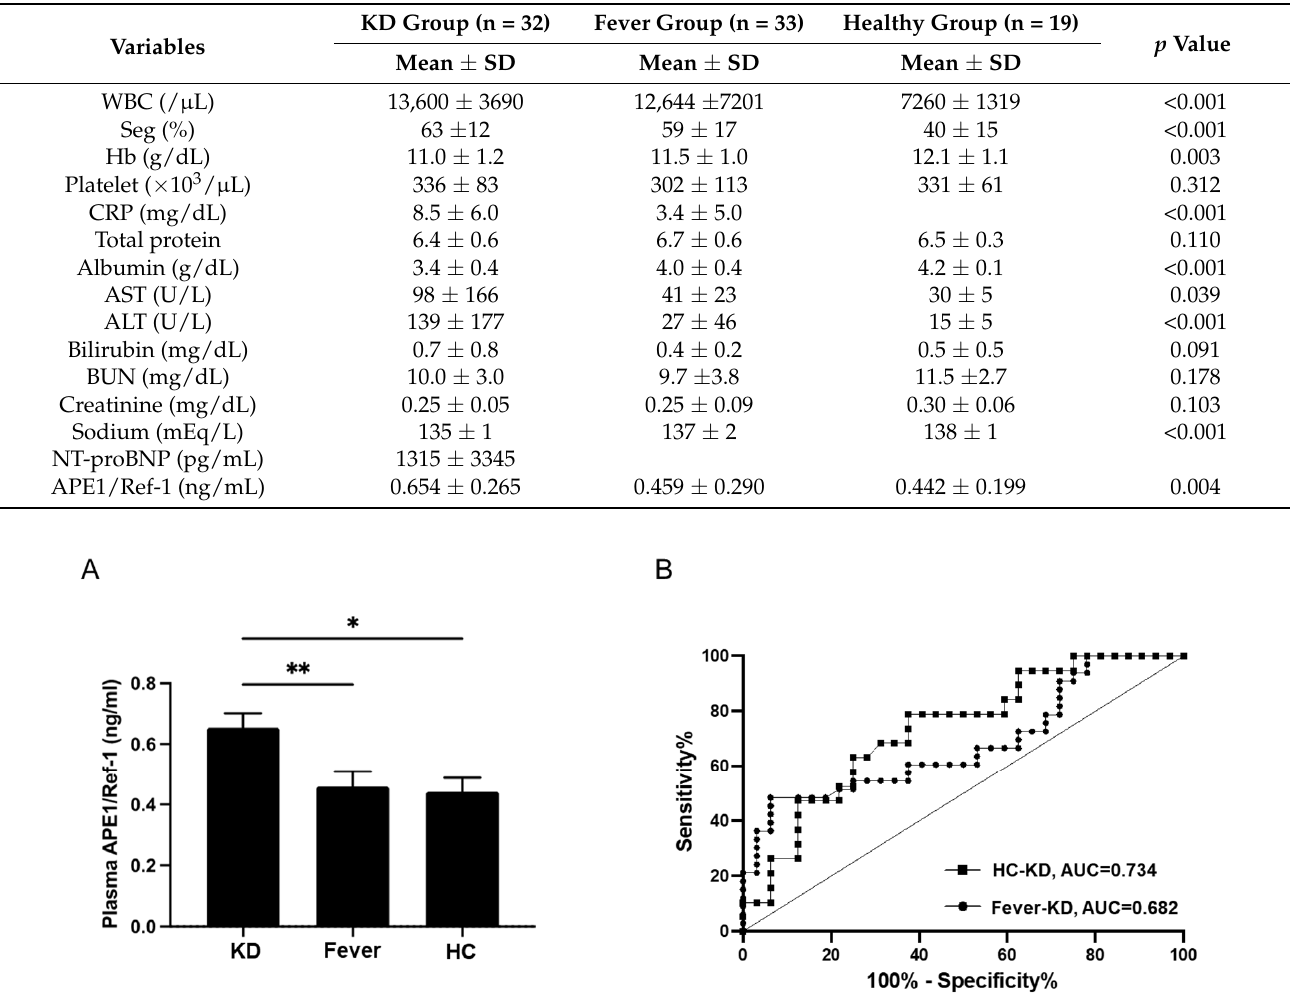
Table 2. Laboratory data.